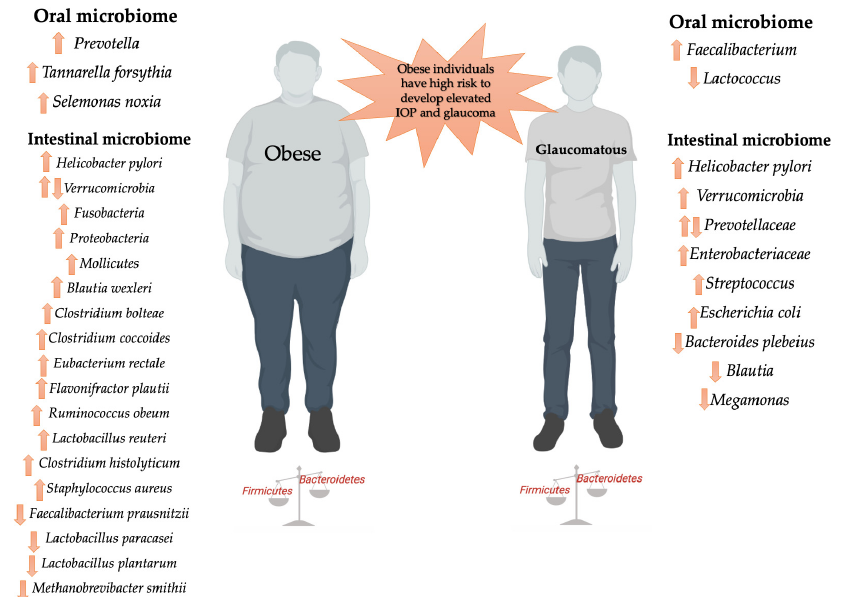
Figure 1. Dysbiosis in obese and glaucomatous individuals is characterized by a decrease in total bacterial diversity and richness, as well as, in general, by a shift toward a community composed of more Firmicutes and fewer Bacteroidetes . Created with BioRender.com (accessed on 23 December 2022) and modified with Microsoft PowerPoint.